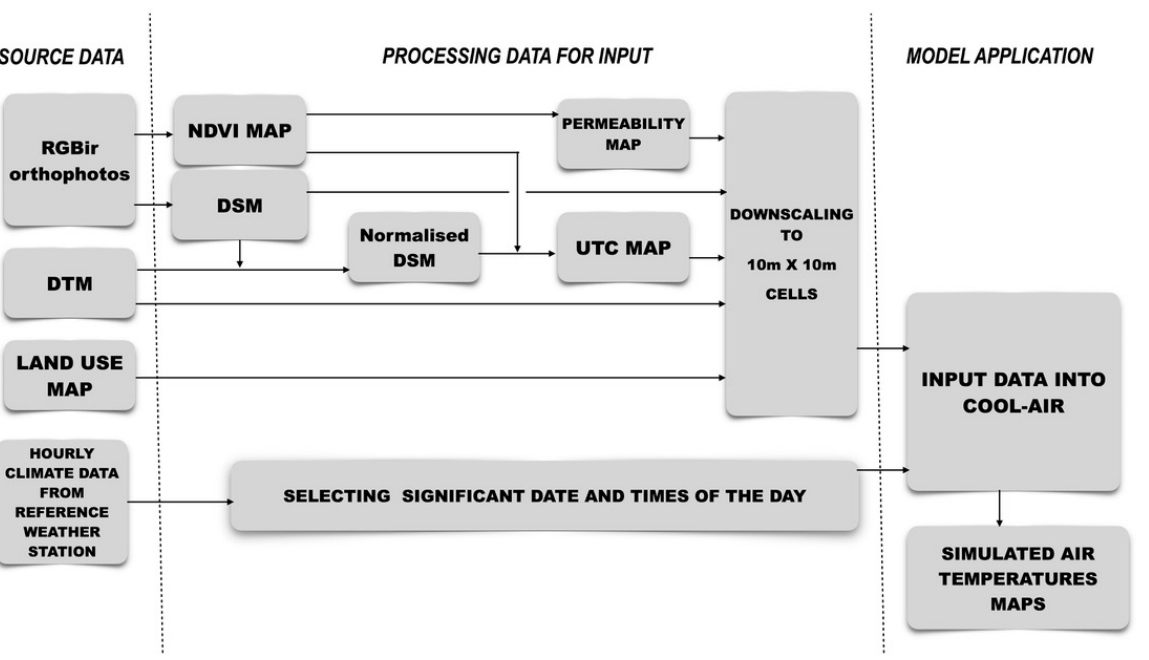
Figure 2. Diagram illustrating the procedure implemented in the study.